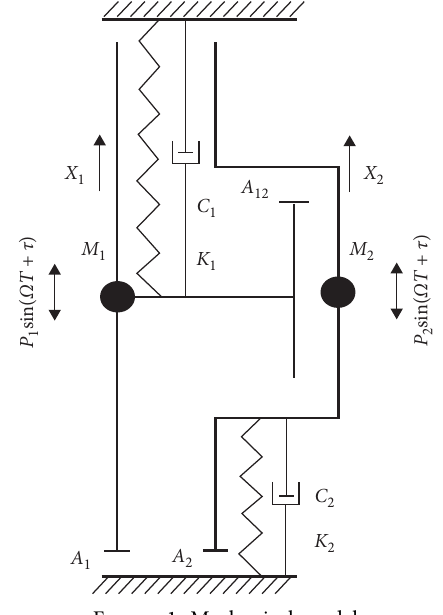
Figure 1: Mechanical